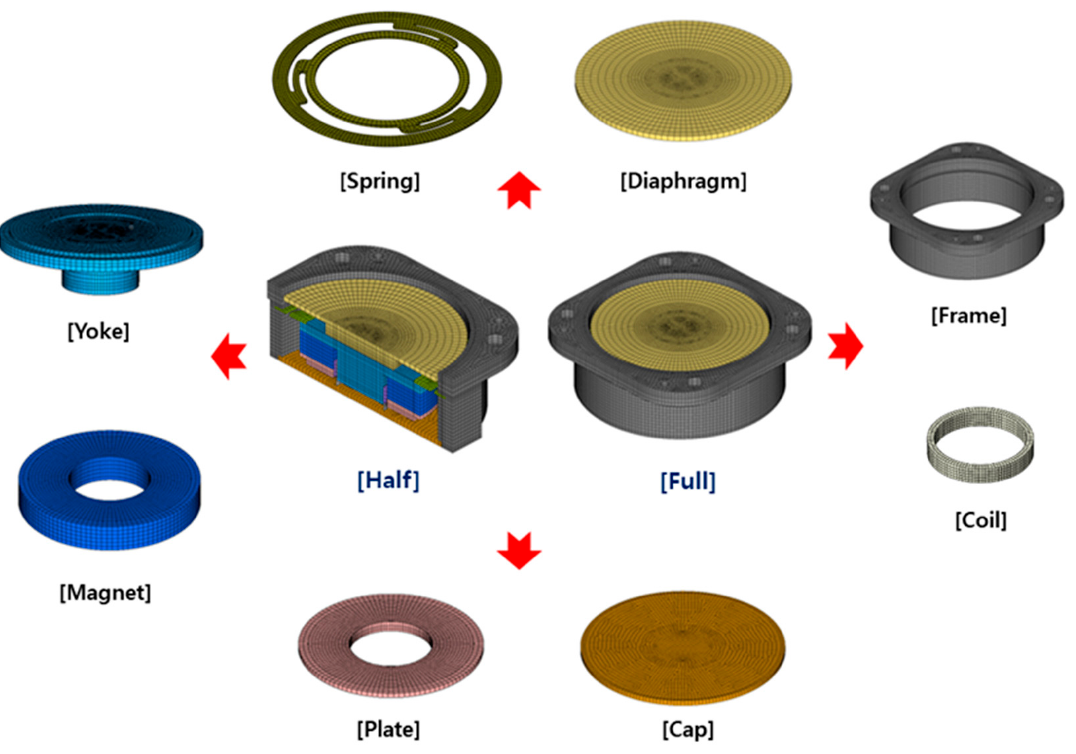
Figure 11. Finite element model of vibration analysis.